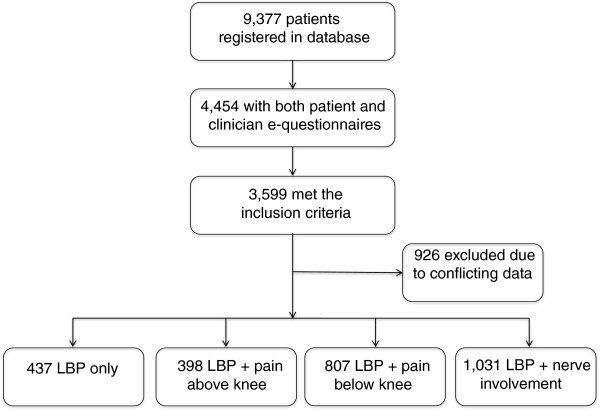
Flow of patients from entering the department to allocation to subgroups in the study.